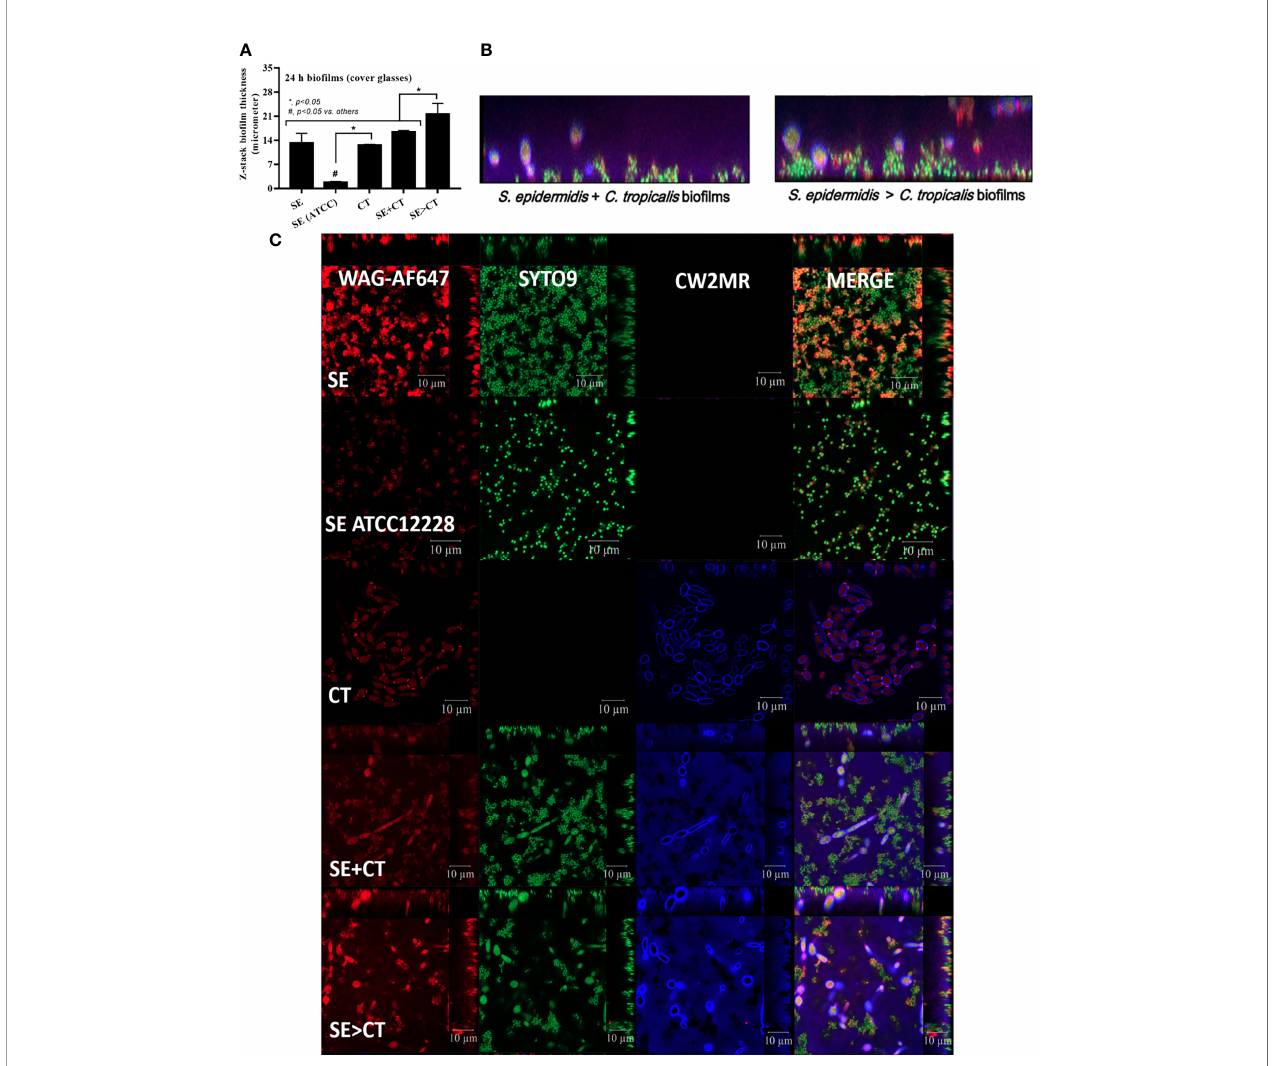
FIGURE 3 | Bio fi lm thickness as evaluated by z-stack analysis of fl uorescent images from 24-h bio fi lms on cover glasses of Staphylococcus epidermidis (SE) using the clinically isolated strain (SE) or the standard strain [SE (ATCC)], Candida tropicalis (CT), SE simultaneously mixed with CT (SE + CT), and preformed SE bio fi lms followed by CT (SE > CT) as indicated by the fl uorescent score using wheat germ agglutinin (WAG)-AF647 (red color fl uorescence) for extracellular matrix, SYTO9 (green color fl uorescence) for bacterial nucleic acid, and calco fl uor white (CW2MR) (blue color fl uorescence) for fungal cell wall, with the representatives fl uorescent images (A – C) demonstrated (independent triplicate experiments were performed). The results were from three independent experiments in triplicate as the mean ± SEM; p < 0.05 was considered statistically signi fi